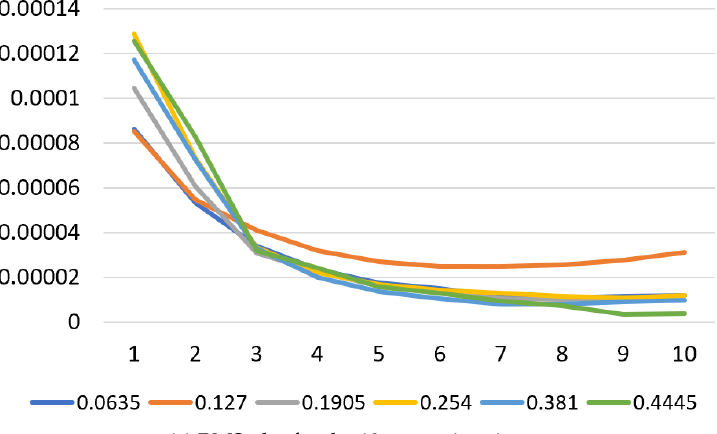
( a ) RMS plot for the 10 approximations . Figure 5.